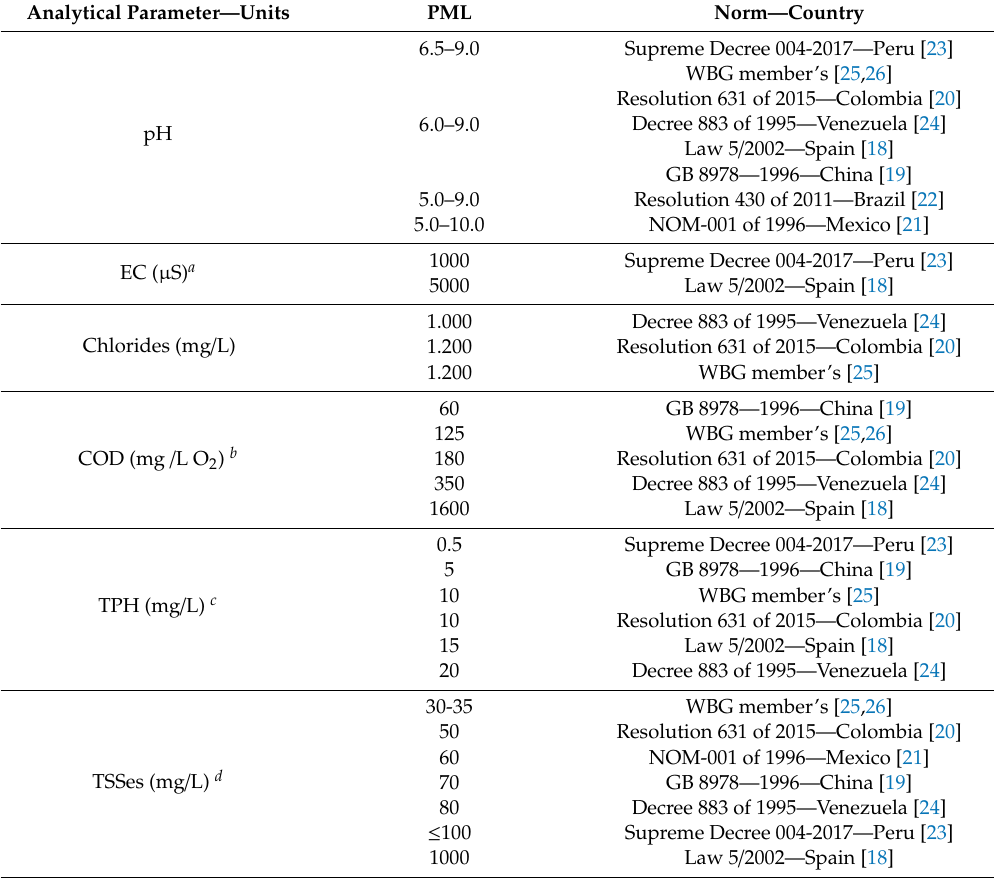
Table 2. National regulations in some oil-producing countries on permissible maximum limits (PMLs) of pollutants in WW for its environmentally safe